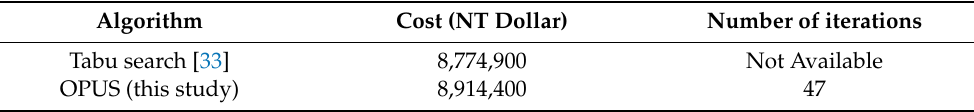
Figure 11. ( a ) Spanning Tree for Taichung Network. Dashed lines are pipes from the original networks that are not included in the Spanning Tree. ( b ) OPUS design for Taichung Network. The diameters are shown in millimeters. Table 6. Reported costs and number of iterations for the Taichung